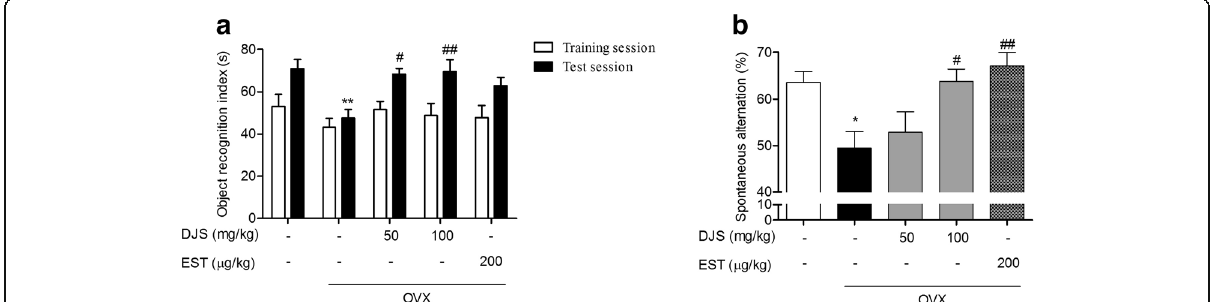
Fig. 2 Effects of DJS on OVX-induced cognitive decline. OVX-induced cognitive decline was determined by novel object recognition test and Y-maze test. Times spent on novel and familiar objects were measured on the novel object recognition test ( a ). Spontaneous alternation behavior and the number of arm entries wre measured on the Y-maze test ( b ). *p < 0.05 and ** p < 0.01 compared with the sham group, # p < 0.05 and ##p < 0.01 compared with the OVX group